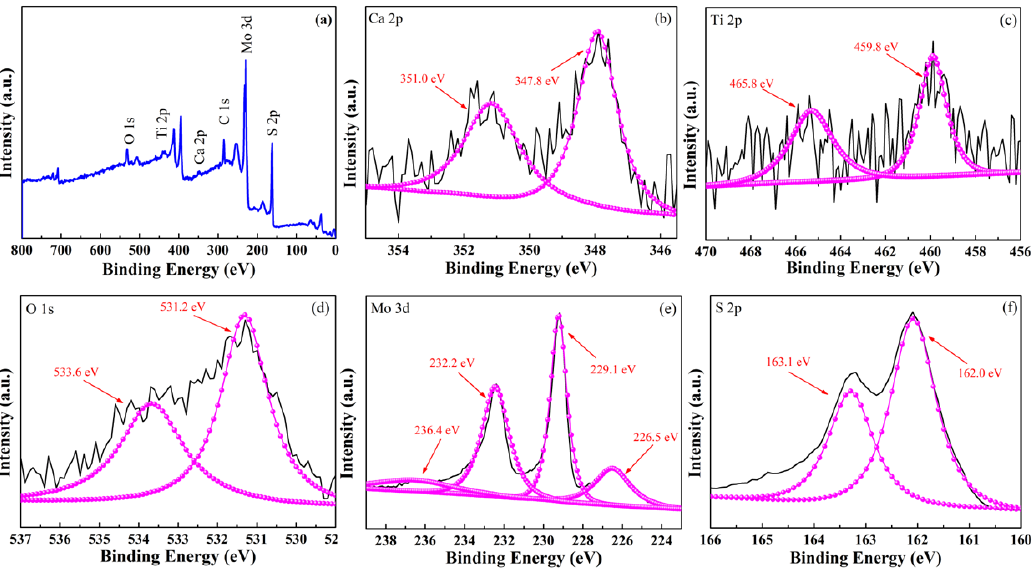
Figure 4. XPS of CTO and MCTO-2, ( a ) full curve, ( b ) Ca 2p spectrum, ( c ) Ti 2p spectrum, ( d ) O 1s spectrum, ( e ) Mo 3d spectrum, and ( f ) S 2p spectrum. spectrum, ( e ) Mo 3d spectrum, and ( f ) S 2p